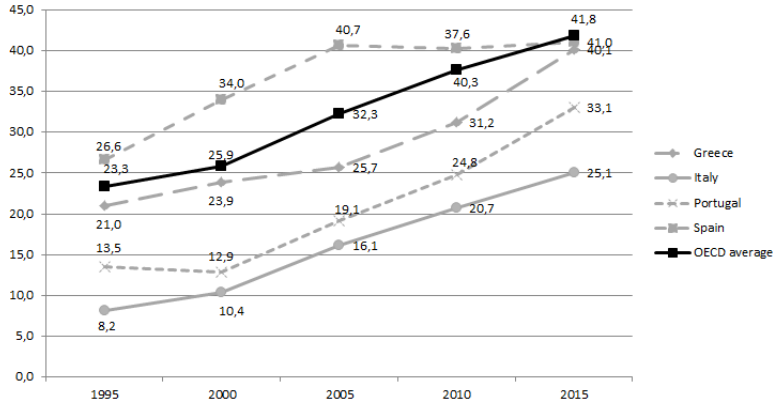
Figure 2: Percentage of the 25-34-year-old population (% in the same age group) with tertiary education 1995-2015